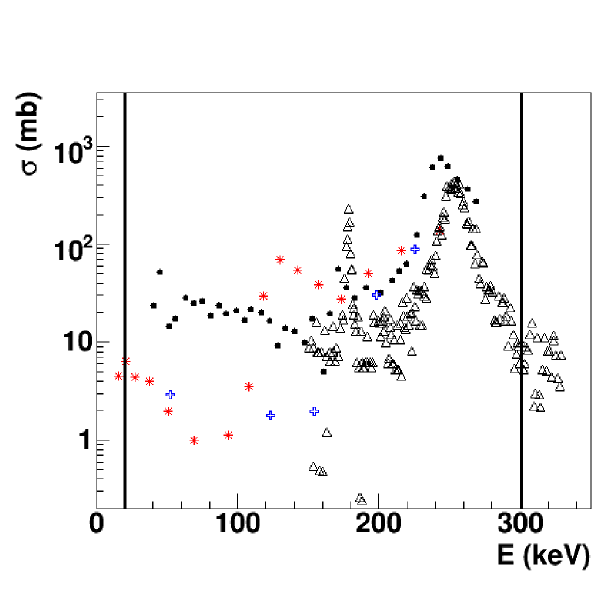
Figure 1. Experimental cross section for the direct measurement of the two body 17 O ( n ,α ) 14 C reaction as available in the literature. Black points are from the data of Sanders et al. [4], red asterisks are from Koehler&Gra ff [5], blue crosses are from Shatz et al. [6], while black triangles are from Wagemans et al. [7]. The vertical black lines approximately indicate the Gamow